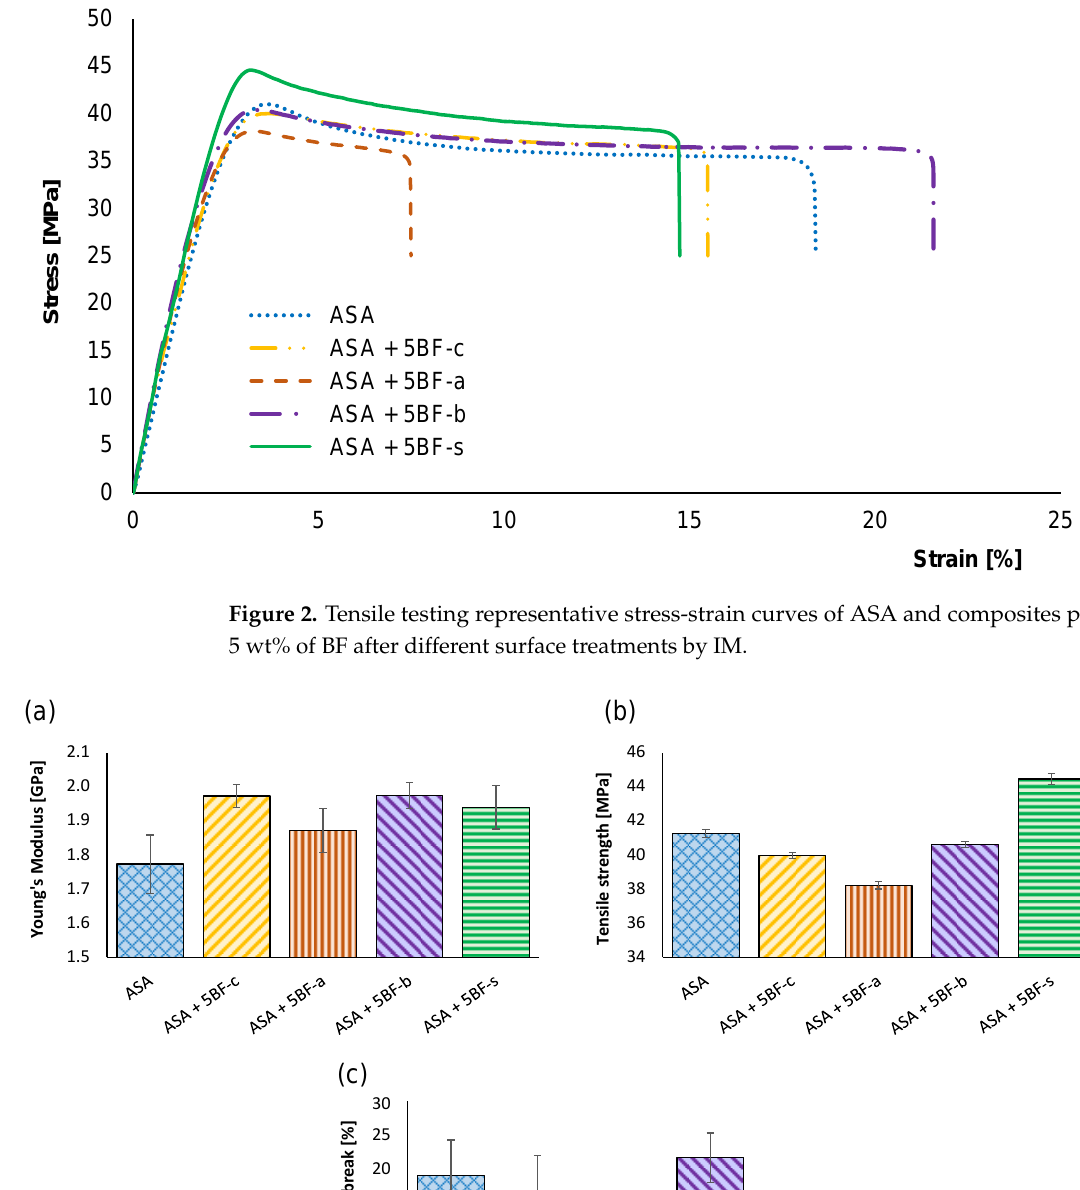
Figure 3. ( a ) Young modulus; ( b ) tensile strength and ( c ) elongation at break of ASA and composites prepared with 5 wt% BF after different surface treatments by IM.